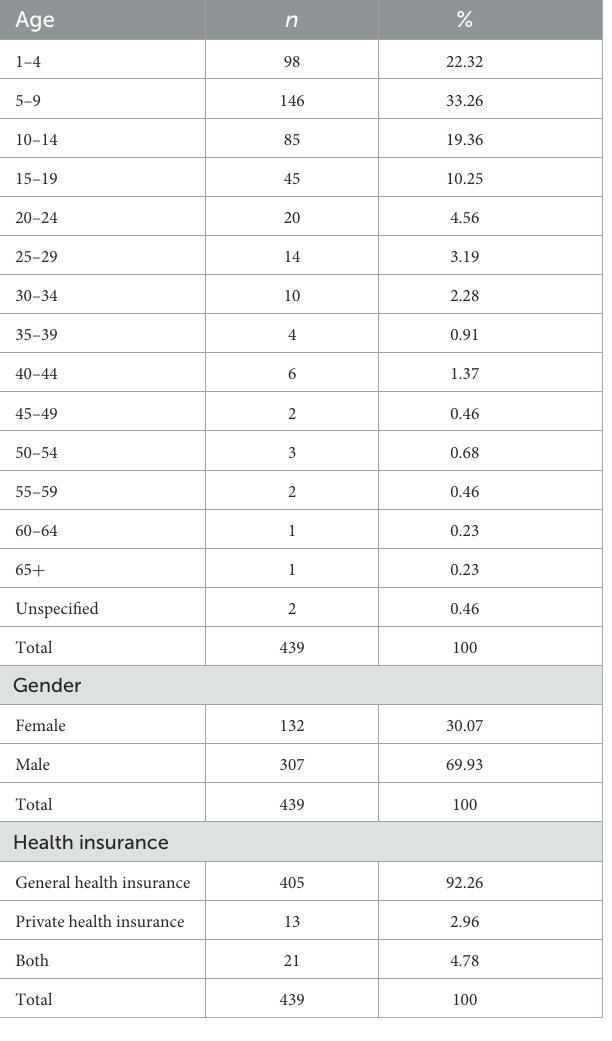
TABLE 1 Demographic characteristics of the